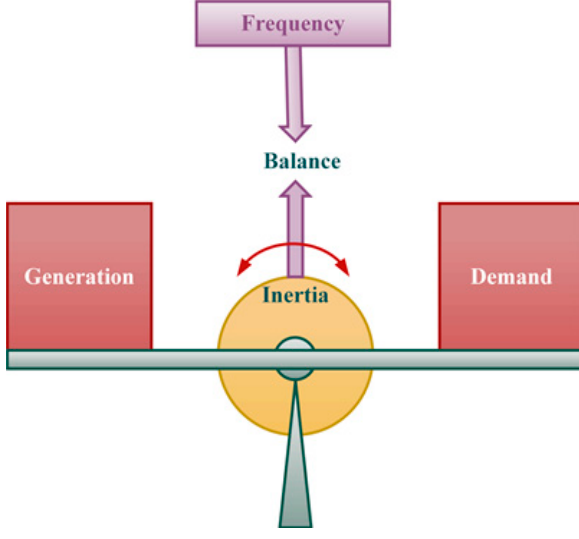
Figure 3. Power balance in a power system network.